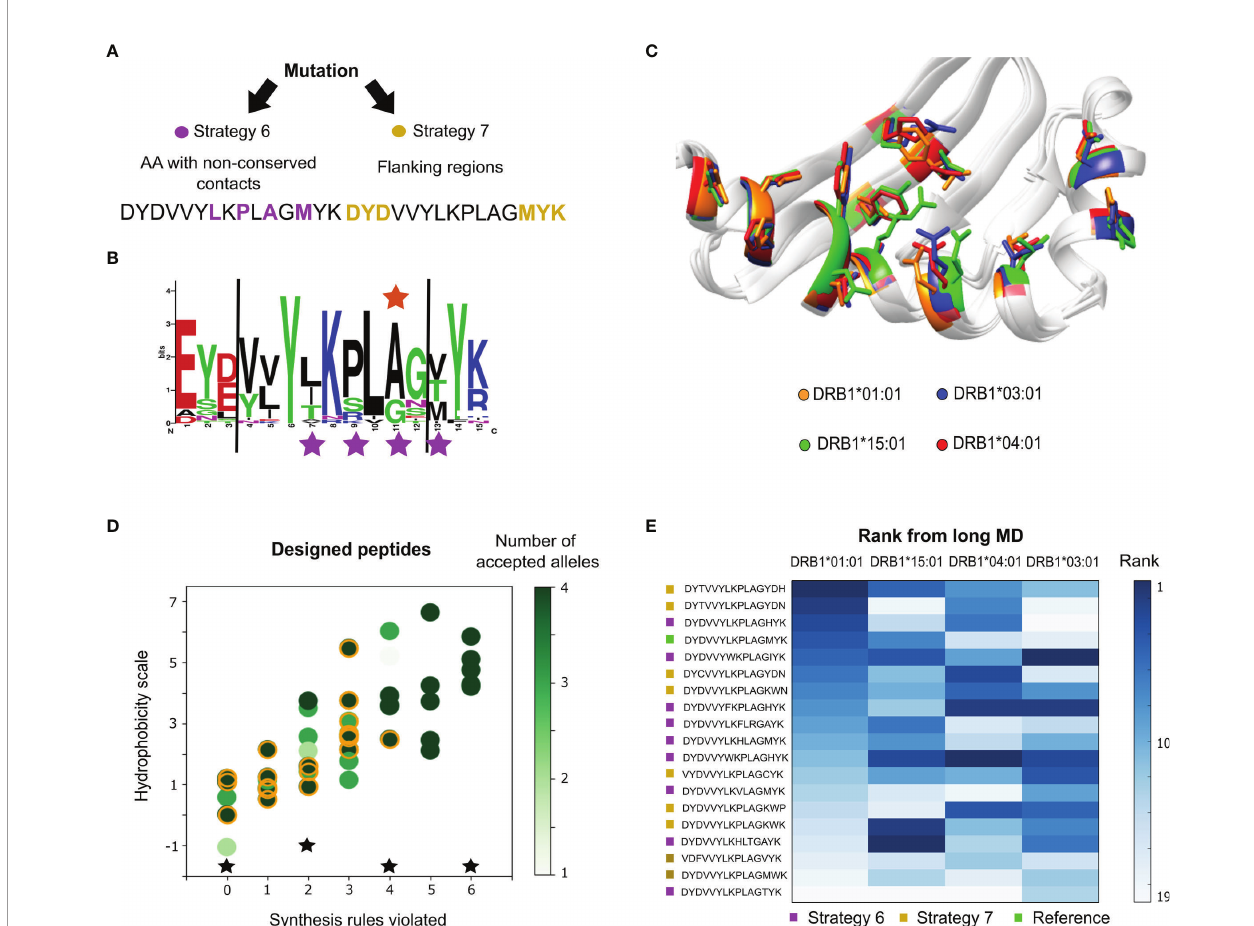
FIGURE 3 | P. vivax epitope design for multiple-allele binding. (A) Mutation strategies implemented by randomly modifying amino acids in the core region with low conservation (strategy 6), and those belonging to the peptide fl anking regions (strategy 7). (B) Logo representation of the alignment showing the frequency of the epitope amino acids at each position. The positions modi fi ed during design strategy 1 are marked with purple stars, and the reported polymorphism is marked with an orange star. (C) Structural view of the polymorphic amino acids from the MHC II b -chain. (D) Hydrophobicity values, the number of synthesis rules violated and the number of alleles where the consensus score criterion was improved for the designed peptides. From a total of 42 peptides, 18 were selected for long MD simulations (orange circles). The controls are represented as black stars. (E) Average rank of the peptide candidates for the four alleles estimated from the long MD. The darker the shade of blue, the higher the rank. The peptides are color-coded according to the two mutation strategies from panel (A) The reference peptide is labeled